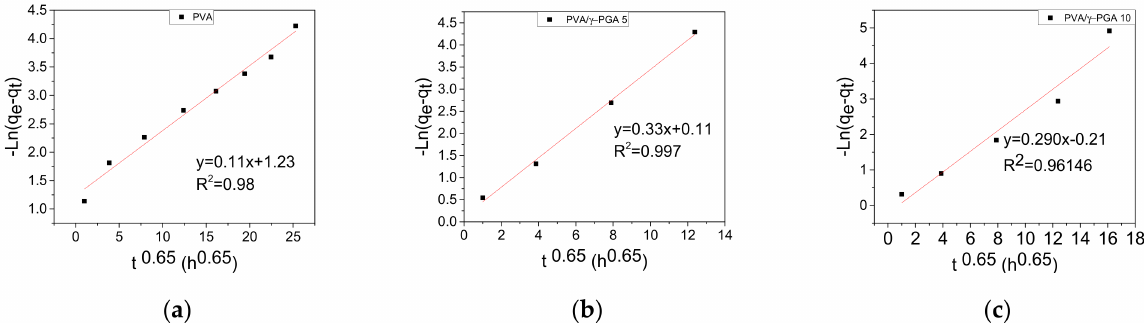
Figure 5. Release of CGA from electrospun fiber mats as a function of t 0.65 at pH 4.8 and 37 ◦ C: ( a ) PVA, ( b ) PVA/ γ -PGA 5 and ( c ) PVA/ γ -PGA